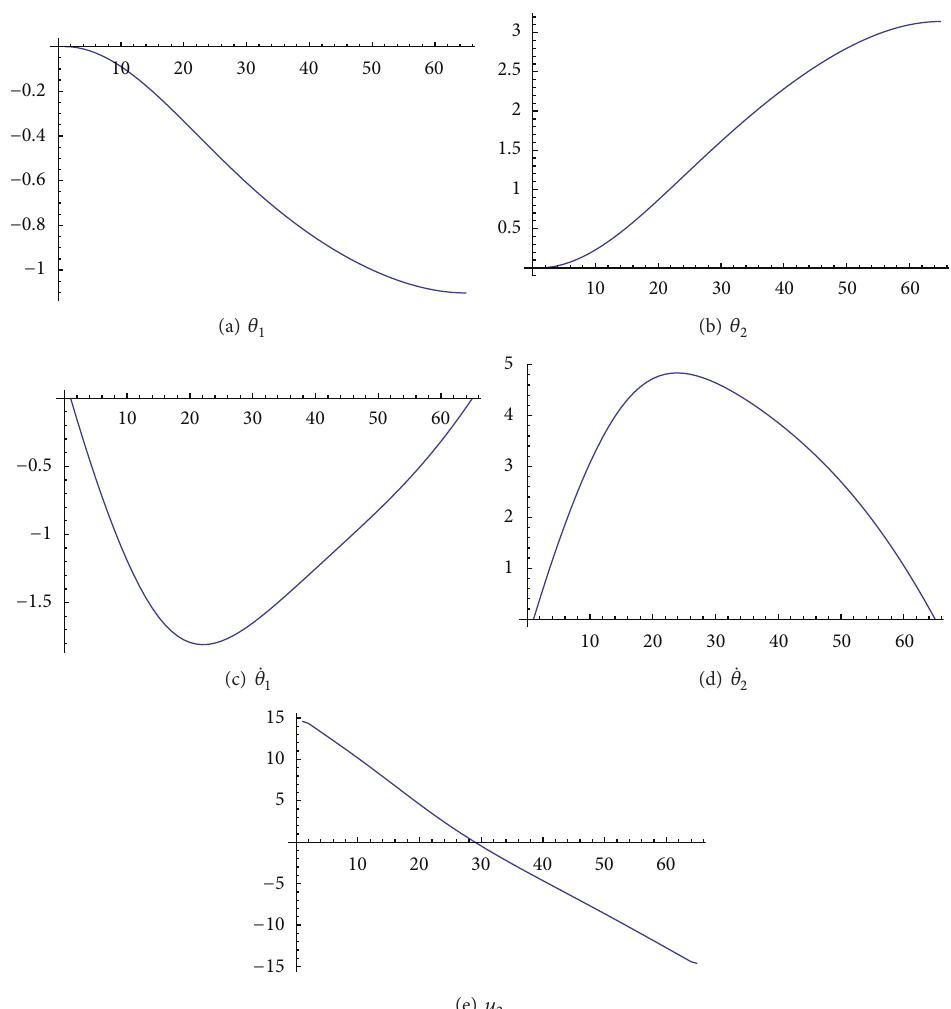
Figure 7: Control and state variables of the optimal solution of problem 3, an initial value problem for an underactuated 𝑅𝑅 planar robot manipulator with boundary conditions 𝜃 1 (𝑡 𝐼 ) = 0 [ rad ] , 𝜃 2 (𝑡 𝐼 ) = 0 [ rad ] , 𝜃 (𝑡 ) = 𝜋 [ rad ] , ̇𝜃 (𝑡 ) = 0[ rad / s ] , and ̇𝜃 2 𝐹 1 𝐹 sequence of configurations of the robot manipulator at times 𝑘(1/32) with 𝑘 = 0,1,...,32 is represented in Figure 6.